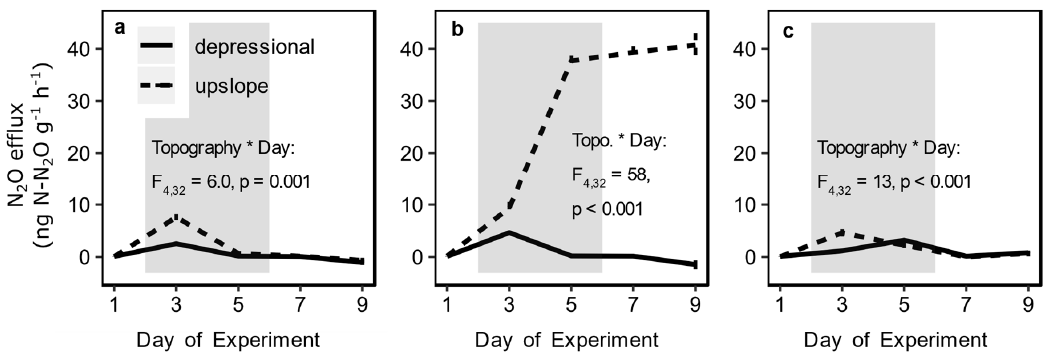
Figure 4. Soil N 2 O emissions (mean ± SE, n = 5) from unamended control soils from the South Farms ( a ), the Energy Farm ( b ), and Cardinal Road ( c ) over the course of the late season experiment. Solid lines represent emissions from depressional soils, and dotted lines represent emissions from upslope soils. Shaded areas represent when the soil cores were flooded. Results from ANOVAs run on linear mixed effects models are presented within each panel. Interaction effects are presented when significant interactions were detected. Otherwise, significant main effects are presented.